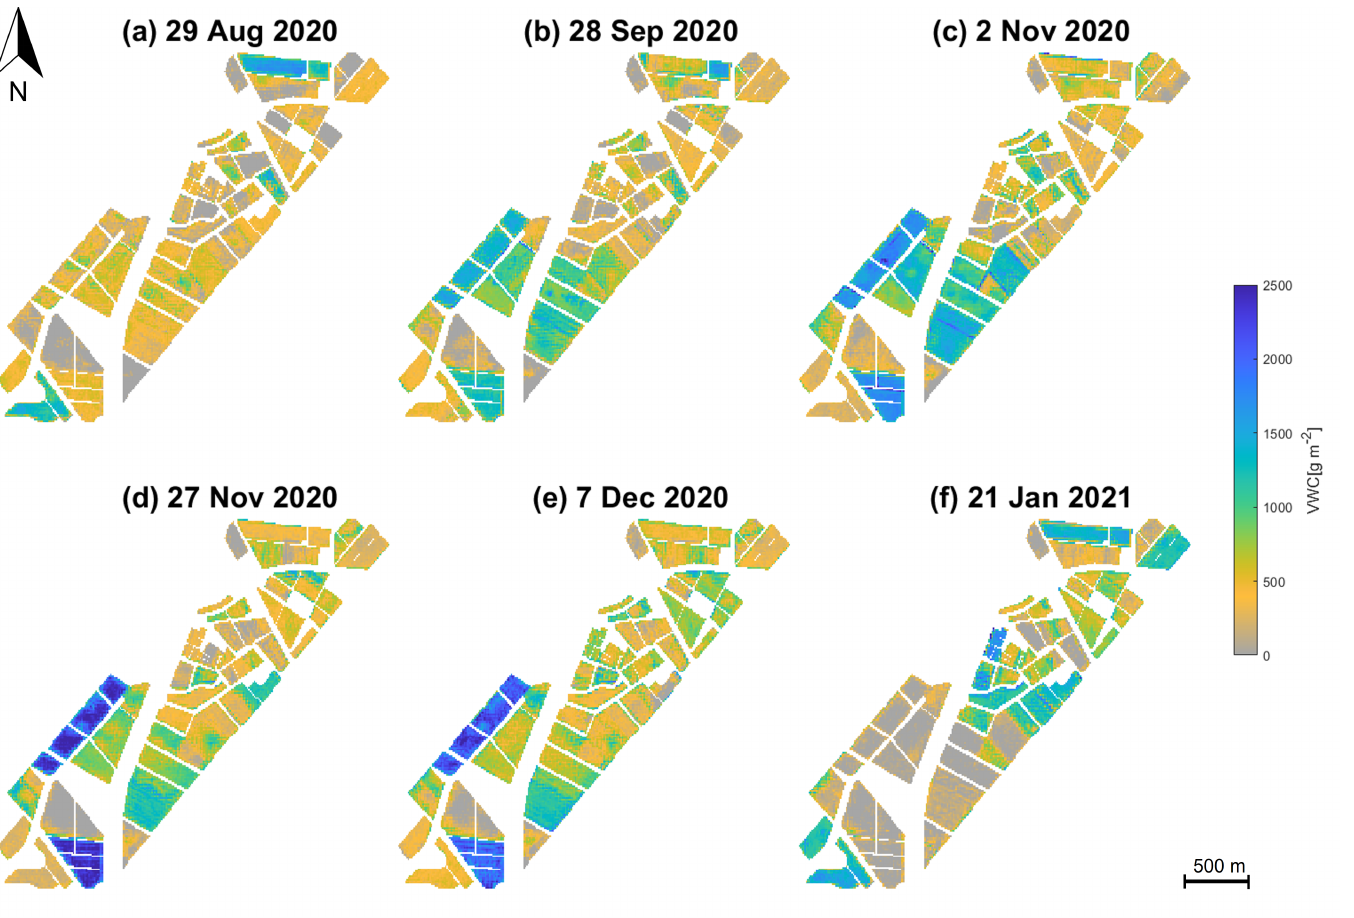
Figure 9. VWC [g m − 2 ] of different crops in the study site, retrieved by the GPR model using simulated vegetation reflectance spectra, in-situ biophysical/biochemical measurements and S2 surface multi-spectral reflectance data. Data obtained from BVCR wheat campaign 2020. ( a ) wheat tillering stage at 29 August 2020; ( b )